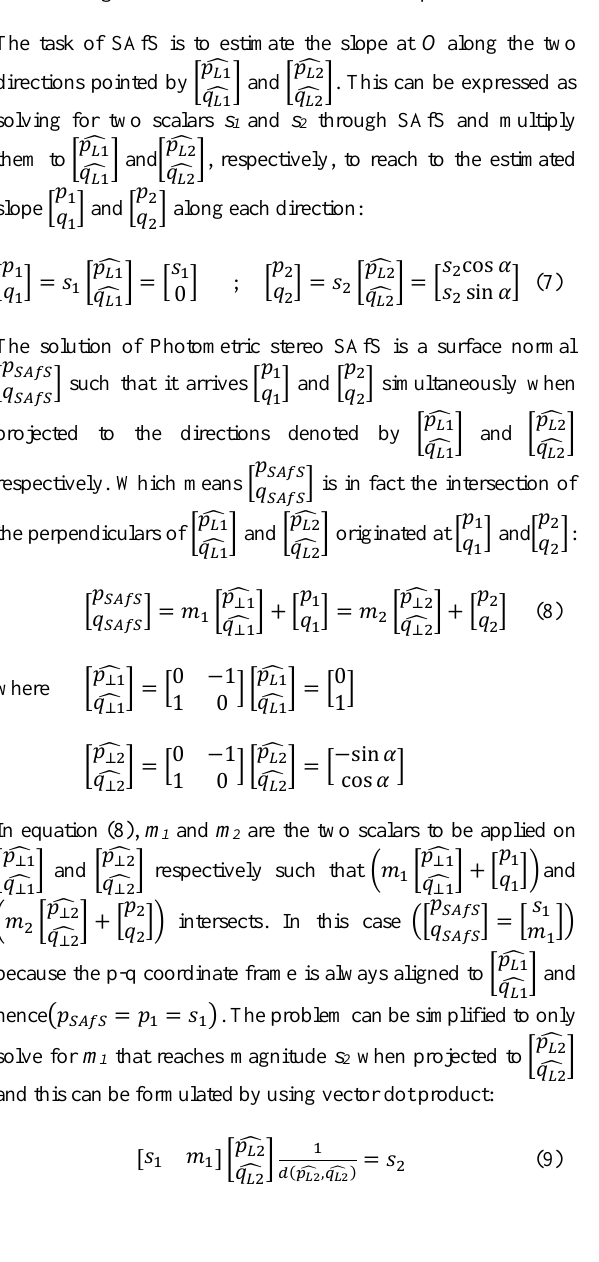
Figure 1. Photometric stereo SAfS at point